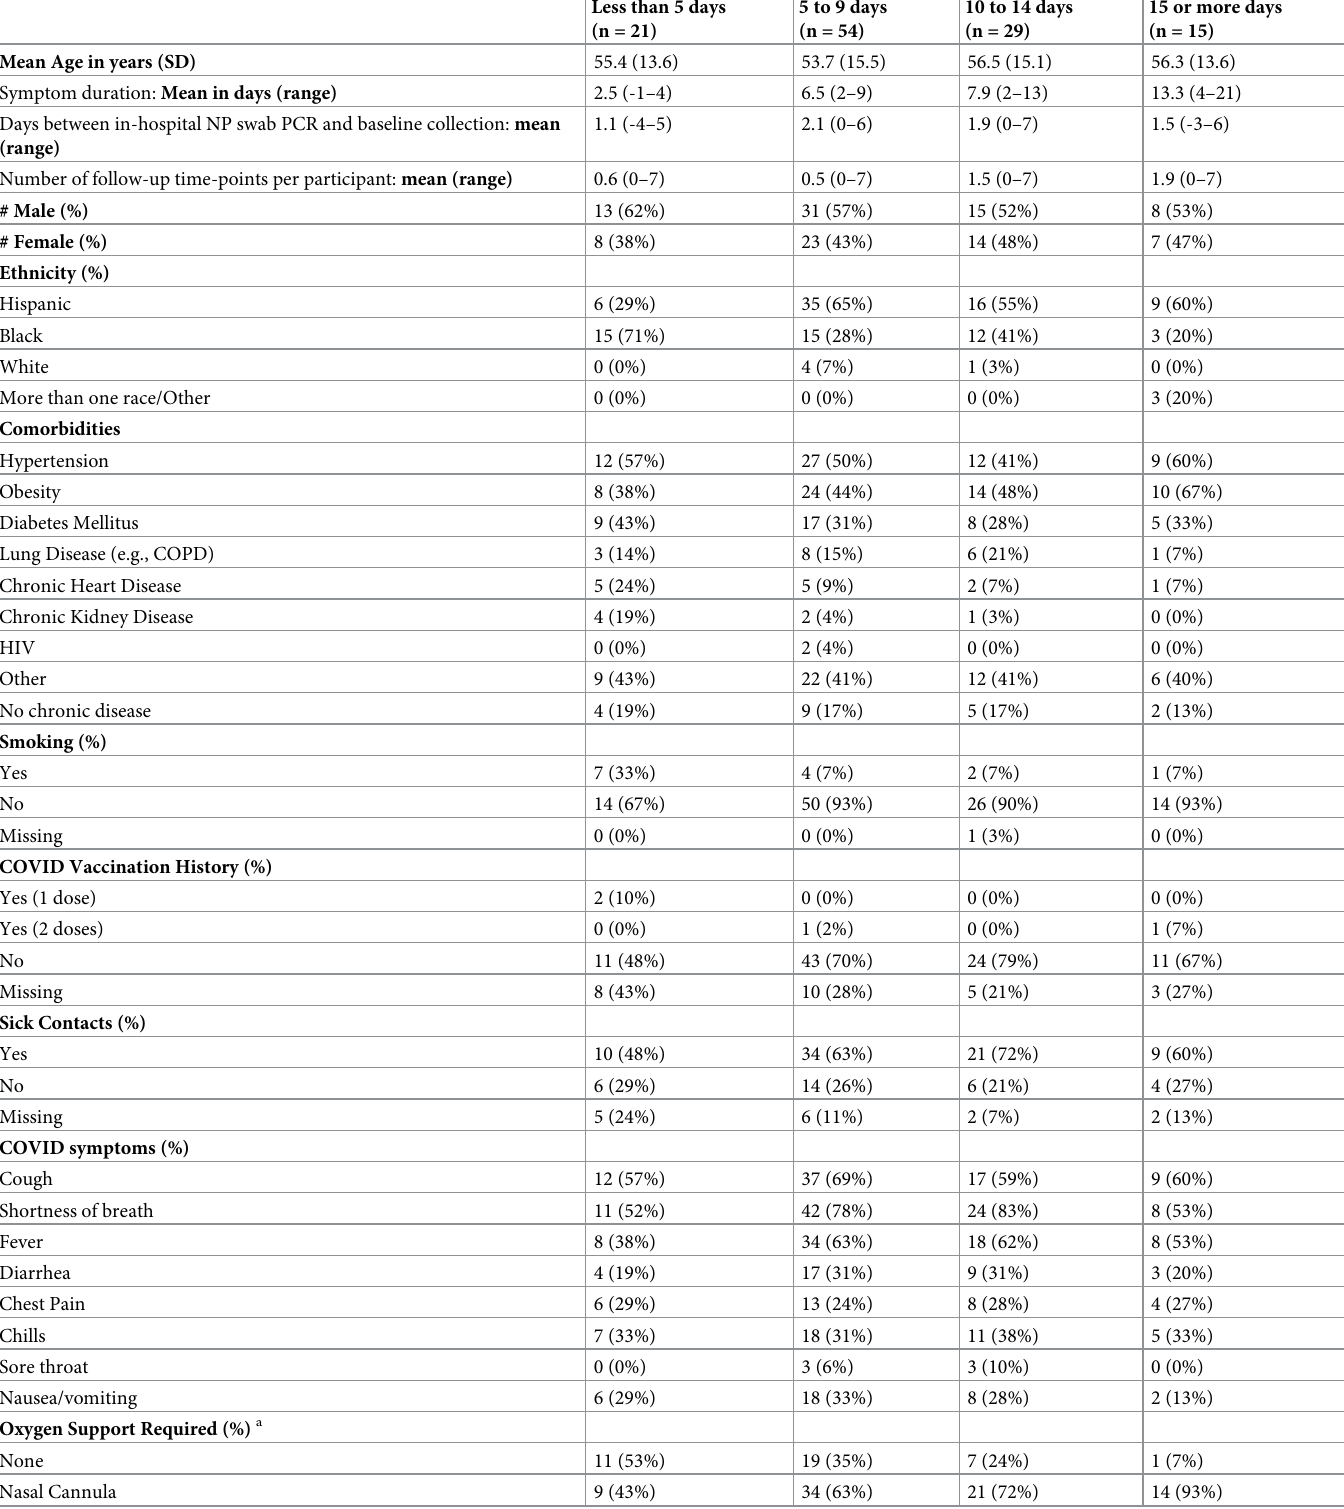
Table 2. Characteristics of participants in the overall analysis cohort by days from symptom